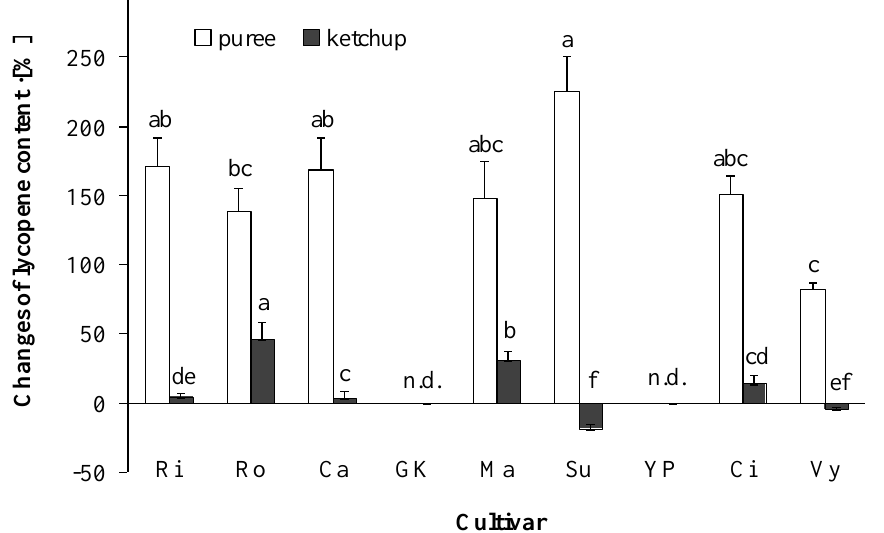
Figure 3. Relative variation in the lycopene content of tomato cultivars depending on processing method: puree and ketchup (Ri—‘Rilia’, Ro—‘Roma’, Ca—‘Campbell-28’, GK—‘Goldene Königin’, Ma—‘Marmande’, Su—‘Suso’ F1, YP—‘Yellow Pearshaped’, Ci—‘CIMA’, Vy—‘Vyta’). The changes were calculated based on data presented in Table 1. The relative variation in the lycopene content of the fresh tomato fruit is 0 by definition. Different letters indicate significant differences within each processing method for cultivars by Duncan test at p ≤ 0.05, n = 16.